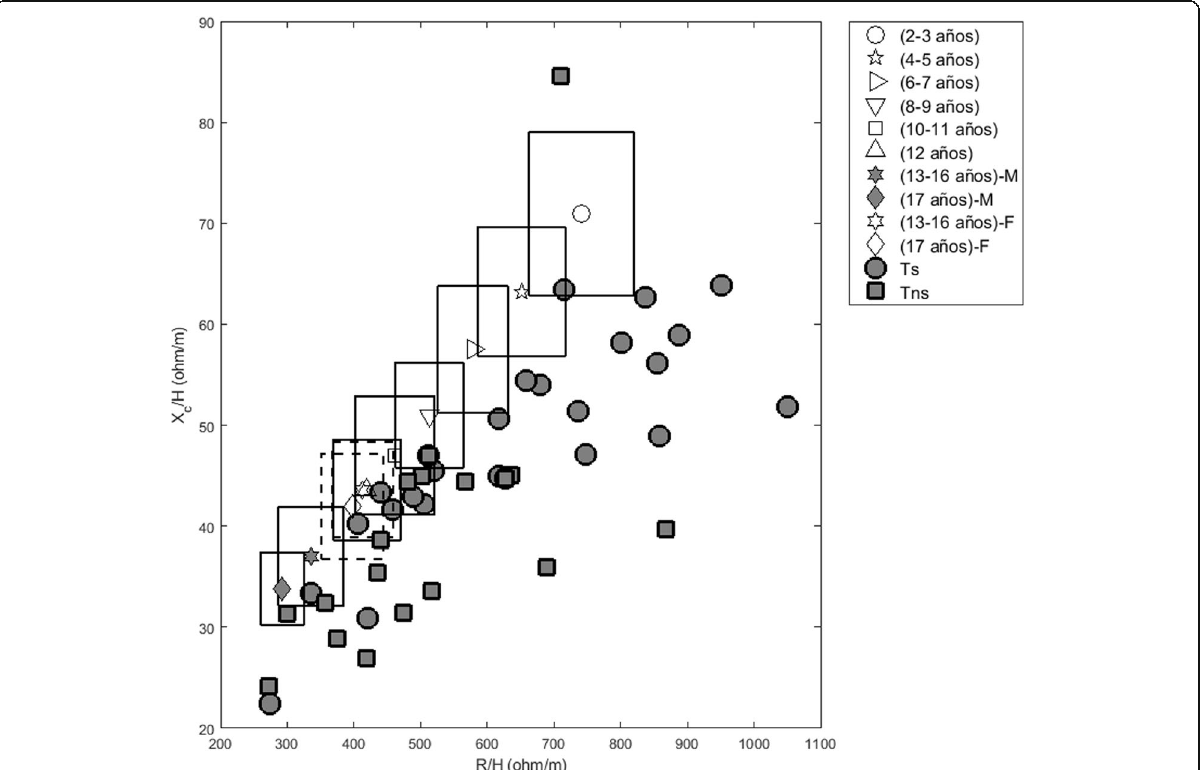
Fig. 2 Set of reference rectangles from 2 to 80 years of age (means ±2 standard deviations [16] were displayed in Table 1 (courtesy of MSc. Alcibiade Lara Lafargue and Centro Nacional de Electromagnetismo Aplicado) and body bioelectric state of each child, for all age groups and gender: male with solid tumor (Ts-M or filled circle), non-solid tumor male child (Tns-M or filled square), female with solid tumor (Ts-F or filled triangle) and non-solid tumor female child (Tns-F or filled